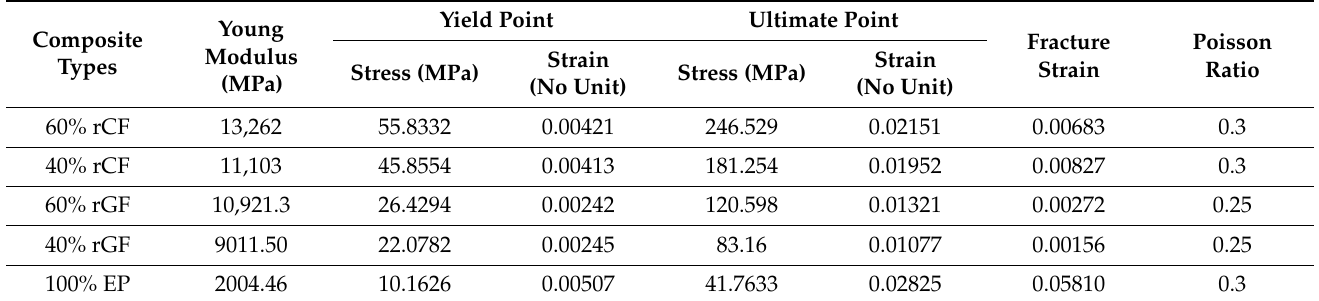
Table 2. Primary input parameters for numerical